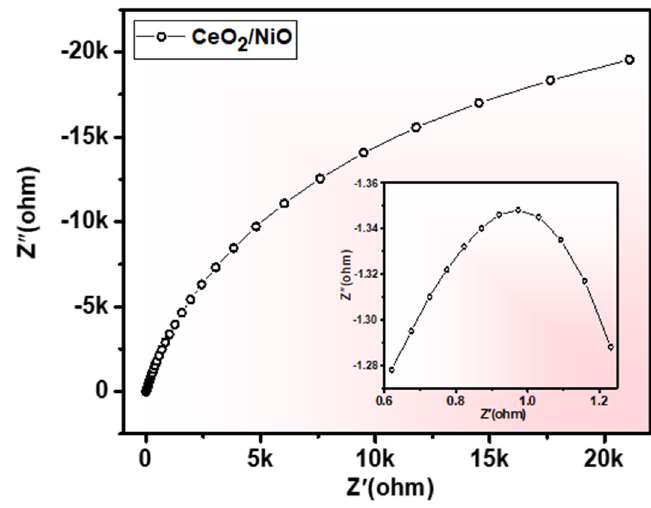
Figure 10. Nyquist plot of CeO 2 /NiO nanocomposite.